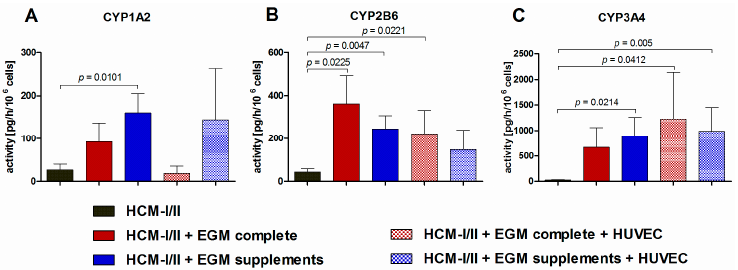
Figure 8. Effect of different media compositions and/or co-culture with human umbilical vein endothelial cells (HUVEC) on activities of cytochrome P450 (CYP) isoenzymes after hepatic differentiation of human induced pluripotent stem cells (hiPSC). Differentiation of definitive endodermal cells was performed over 14 days using hepatocyte culture medium (HCM-I/II), a 1:1 mixture of hepatocyte culture medium and endothelial cell growth medium, consisting of basal medium and supplements (HCM-I/II + EGM complete) or HCM enriched with endothelial cell growth supplements (HCM-I/II + EGM supplements) with or without HUVEC addition. The graphs show activities of CYP1A2 determined by measuring the conversion rates of phenacetin to acetaminophen ( A ), activities of CYP2B6 determined by measuring the conversion rates of bupropion to 4-OH-bupropion ( B ) and activities of CYP3A4 determined by measuring the conversion rates of midazolam to 1-OH-midazolam ( C ) over 6 h. Differences between HCM and all other groups and differences between test media and their corresponding co-cultures were detected using the unpaired, two-tailed Student’s t -test, HCM: n = 8; HCM-I/II + EGM complete and HCM-I/II + EGM Supplements: n = 7; co-cultures: n = 3; mean ± standard error of the mean.